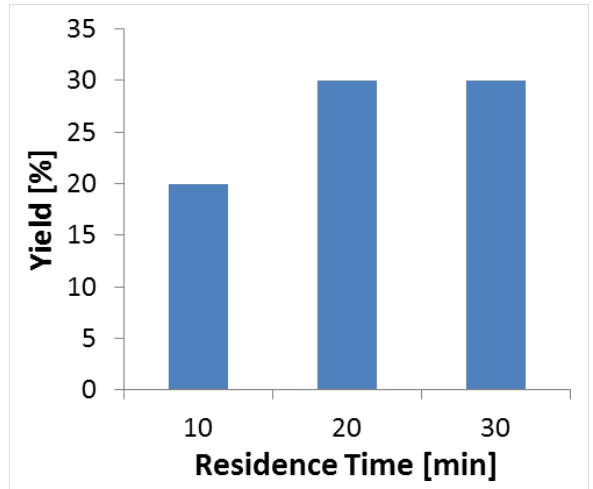
Figure 6: Effect of flow rates on yield for immobilized enzymes in a packed bed microreactor (70 °C). Reaction conditions: Reaction volume (0.250 mL), TA (1.1 mg, specific activity – 0.052 U/mg), temperature (70 °C).